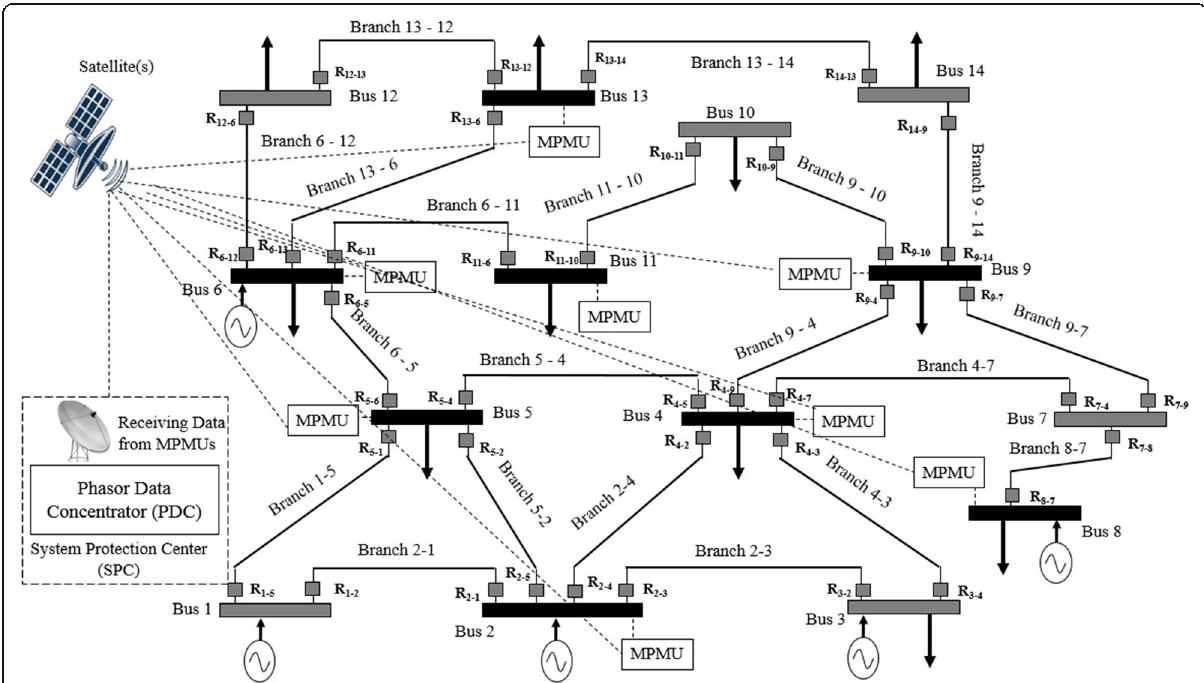
Fig. 4 Single line diagram of IEEE-14 bus